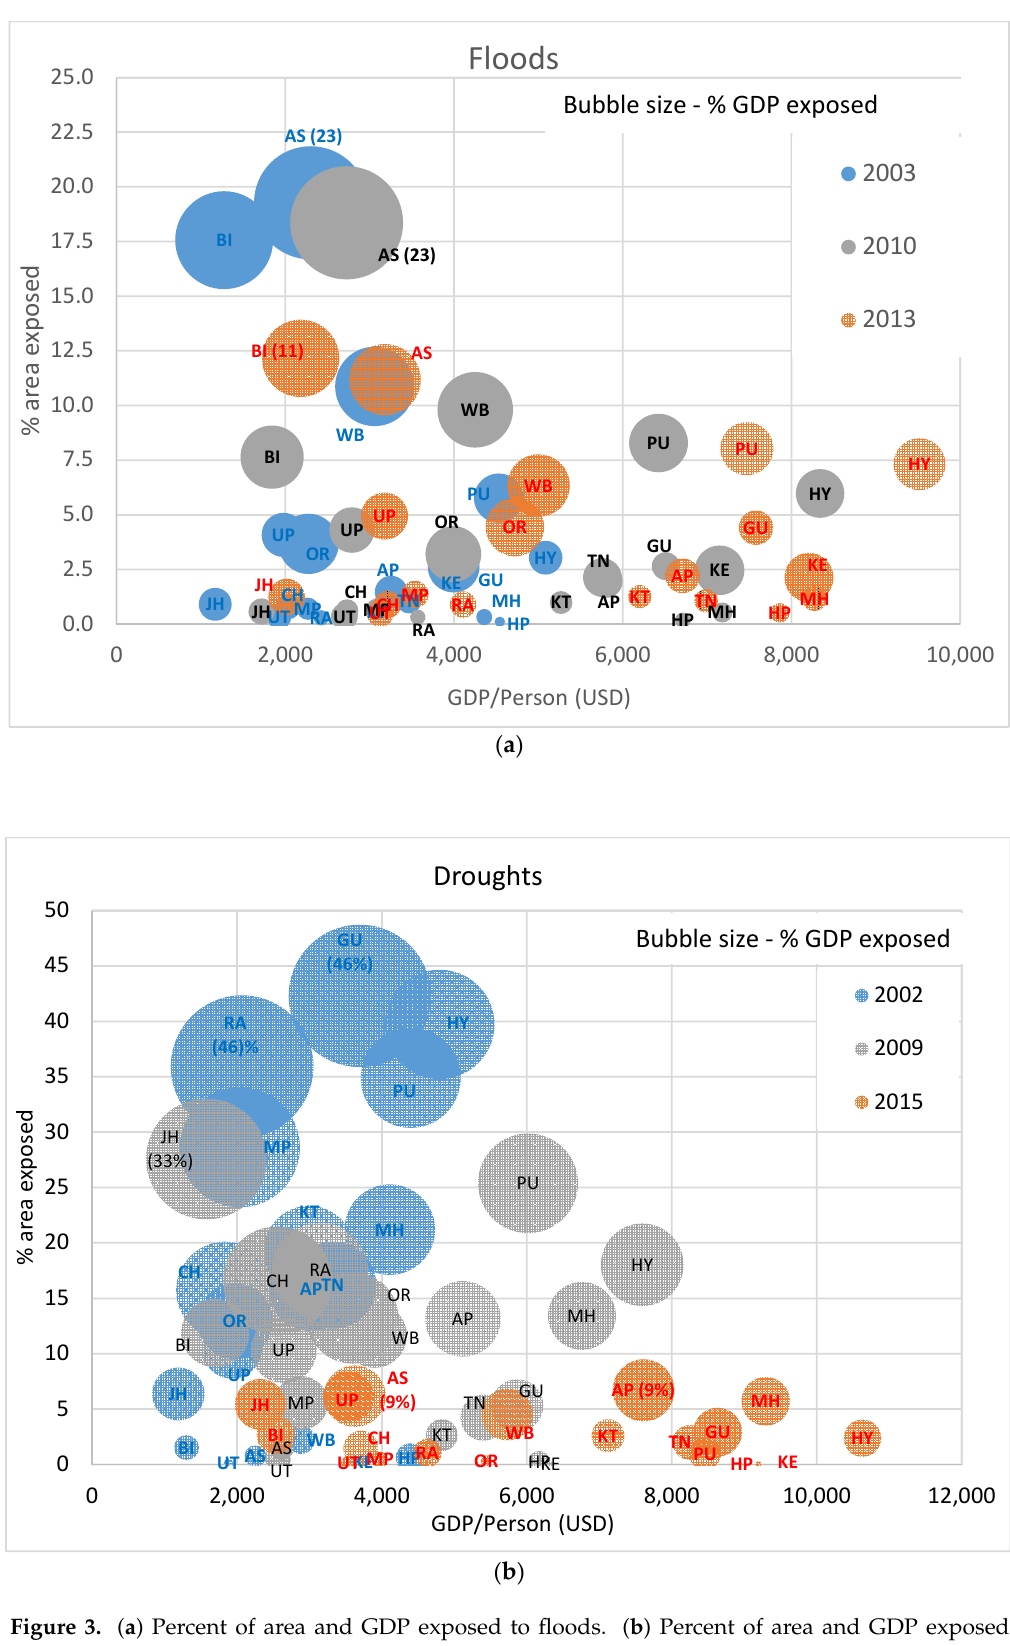
Figure 3. ( a ) Percent of area and GDP exposed to floods. ( b ) Percent of area and GDP exposed to